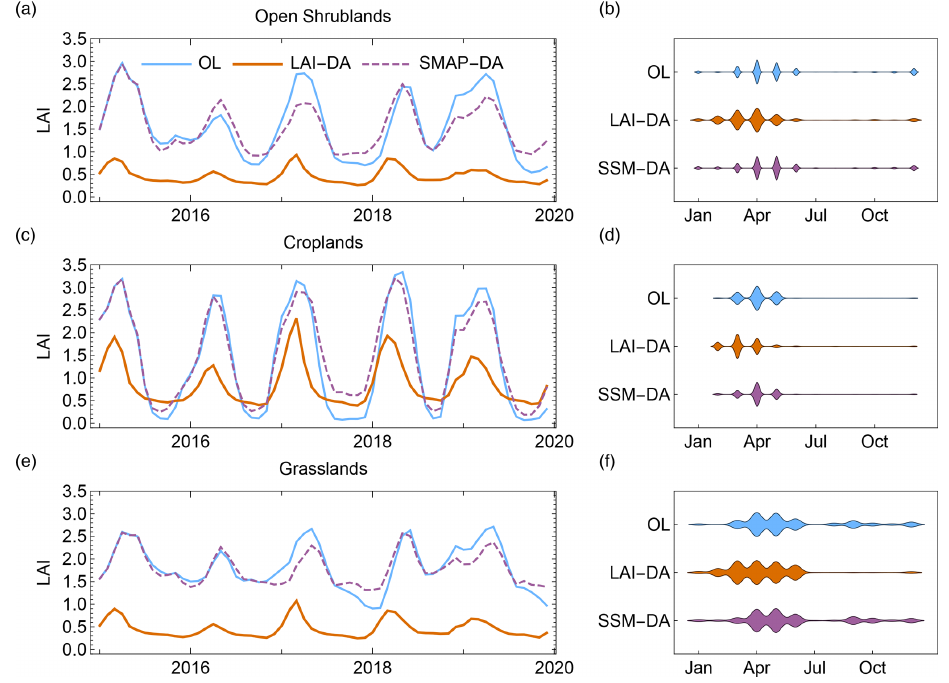
Figure 4. Monthly time series of LAI estimated from OL, LAI-DA, SSM-DA, and the corresponding distribution of peak LAI month for